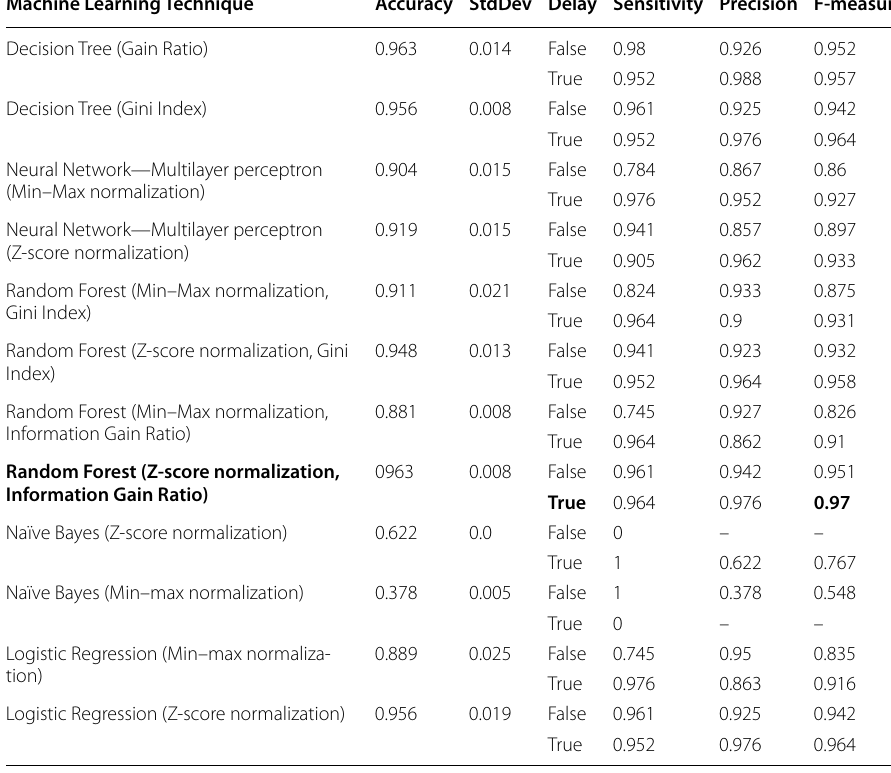
Optimal model is denoted with the bold font